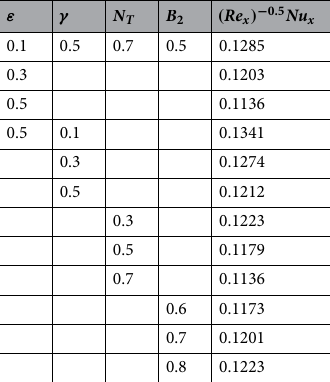
Table 3. Numerical outcomes of the heat transfer rate ( Re x ) − 0.5 Nu x for different value of ε , γ , N T and B 2 .